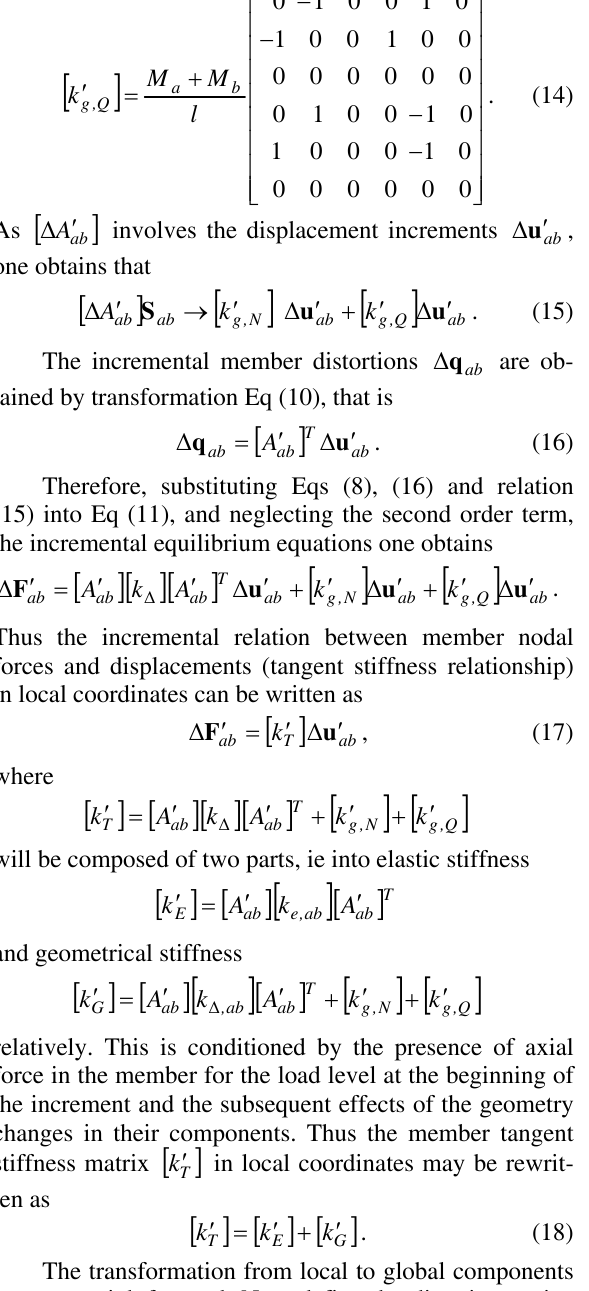
Fig 3. Computational